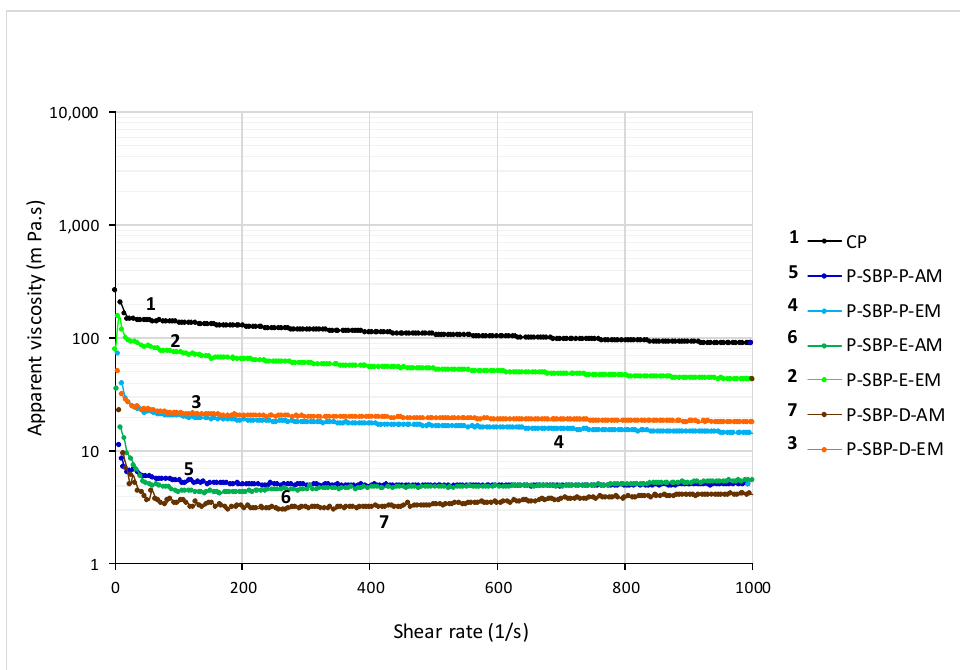
Figure 5. Apparent viscosity of pectin solutions (20 mg/mL). CP: citrus pectin. P - SBP-P-AM: pectin of sugar beet pulp pressed, acid method. P - SBP-P-EM: pectin of sugar beet pulp pressed, enzymatic method. P - SBP-E-AM: pectin of sugar beet pulp ensiled, acid method. P - SBP-E-EM: pectin of sugar beet pulp ensiled, enzymatic method. P - SBP-D-AM: pectin of sugar beet pulp dried, acid method. P - SBP-D-EM: pectin of sugar beet pulp dried, enzymatic method.